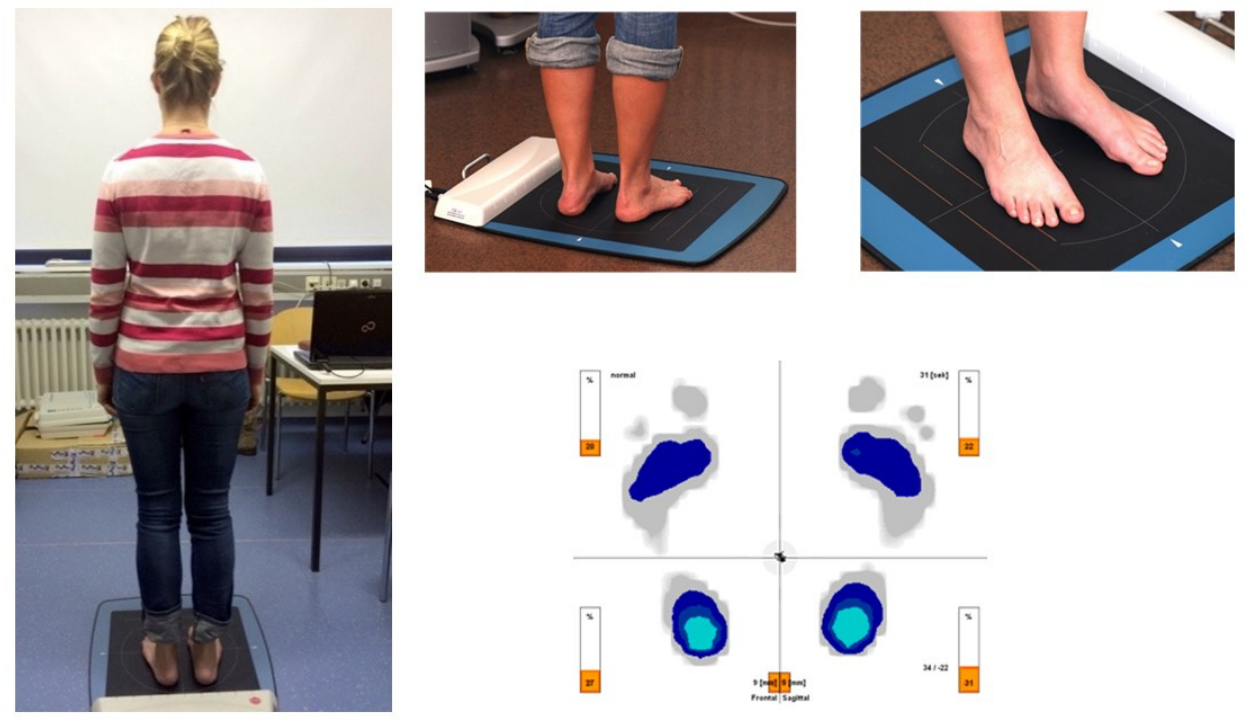
Figure 1. Experimental study setup.